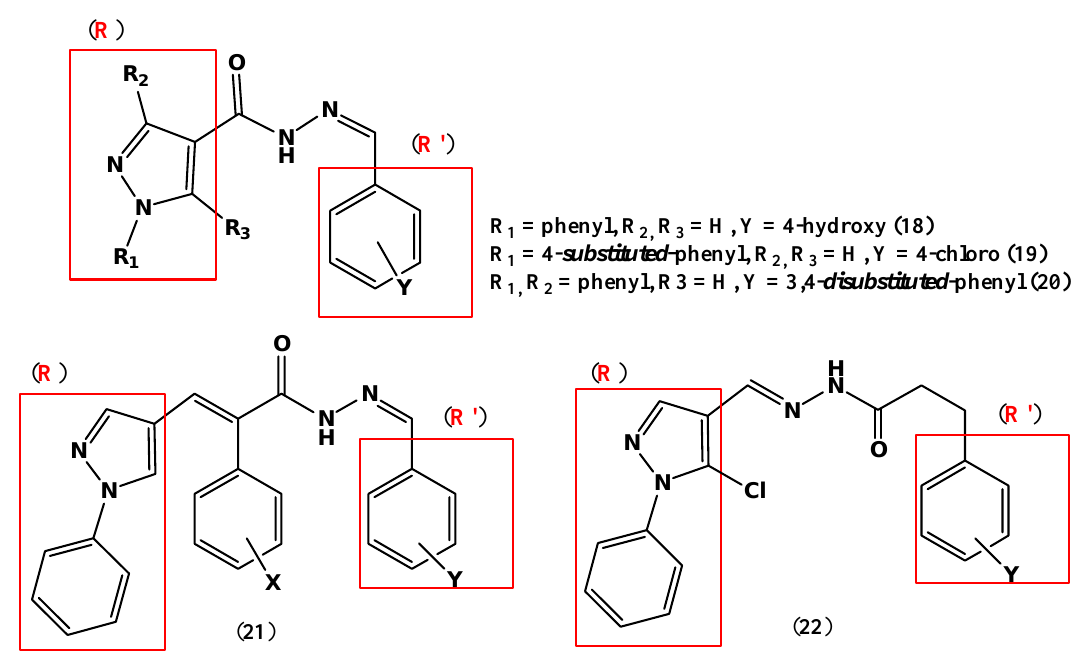
Figure 5. 1- H -pyrazole-4-carbohydrazide derivatives which show antimicrobial activity (compounds 18 – 21 ) and anticonvulsant activity (compound 22